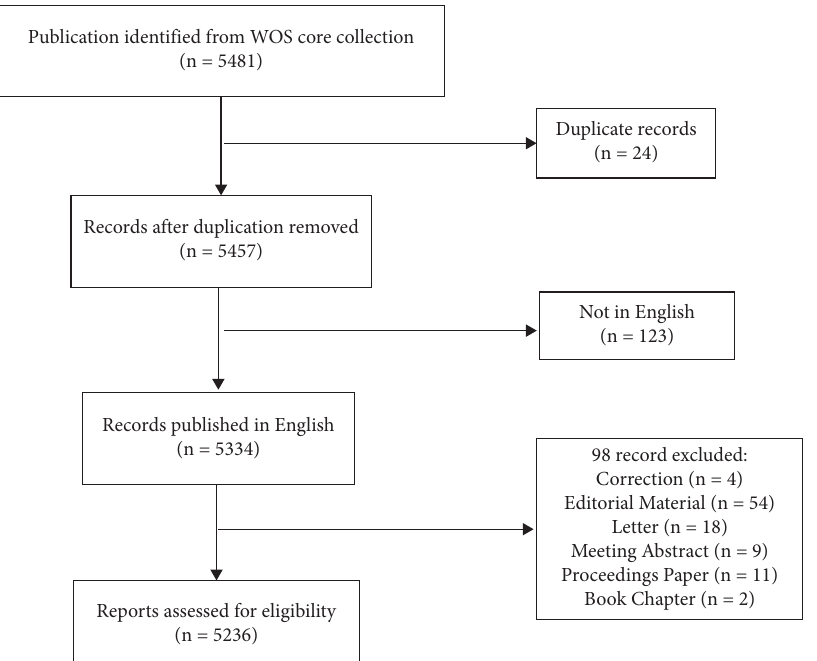
Figure 1: Flow chart of study